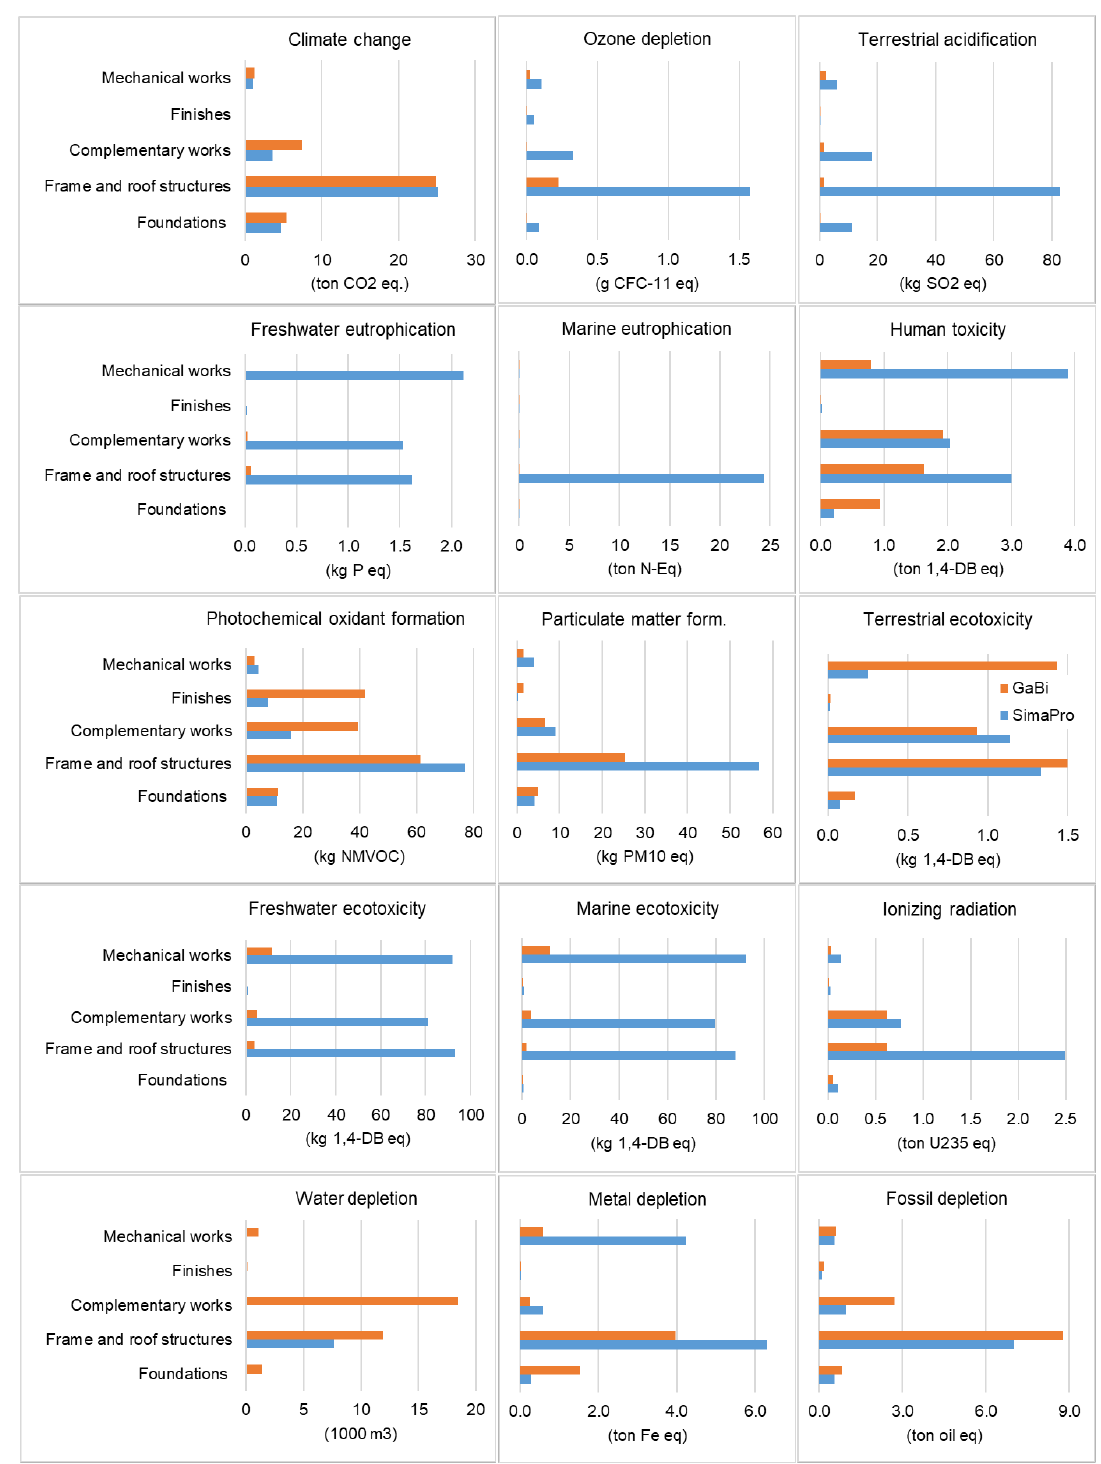
Figure 3. Breakdowns of 15 environmental impacts of KÄPYLÄ by building system. The authors would like to apologize for any inconvenience caused to the readers by these changes. The changes do not a ff ect other scientific results and conclusions. The manuscript will be updated, and the original will remain available. A link to this correction will be